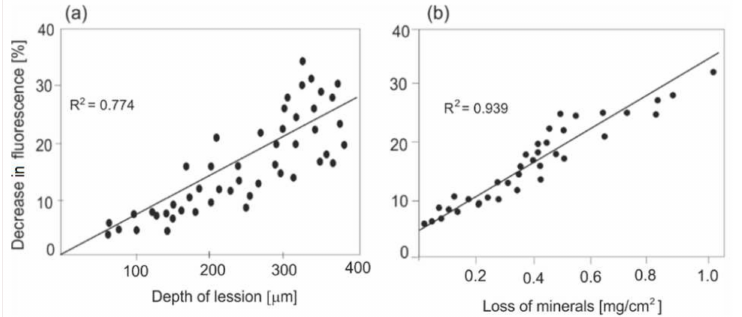
Figure 6. Influence of the ( a ) depth of the lesion and ( b ) loss of minerals on the decrease in fluorescence